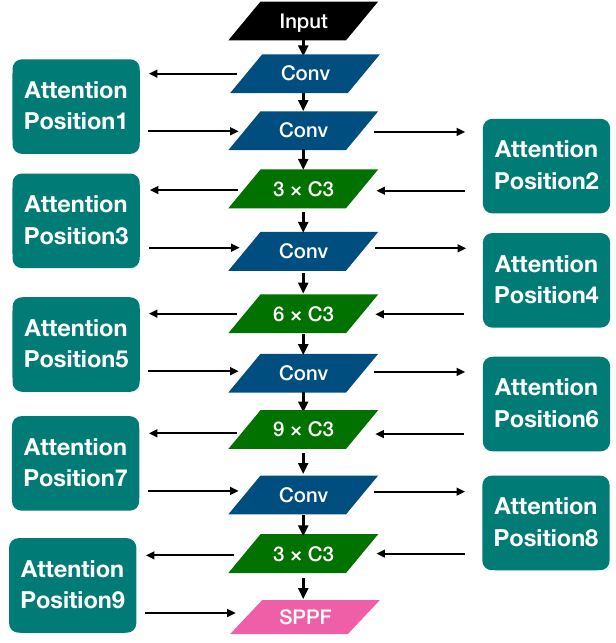
Figure 8. The corresponding map of the position relationship added by the Attention Mechanism in the Backbone. For example, if the CA mechanism is fused at Position 1, then the fusion network is named YOLOv5 +